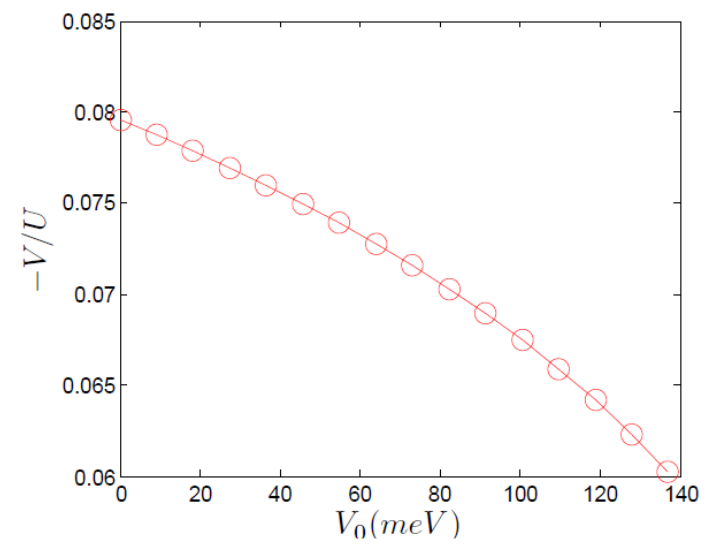
axis is in units of 0 range from V = 0 to its expected value for 0